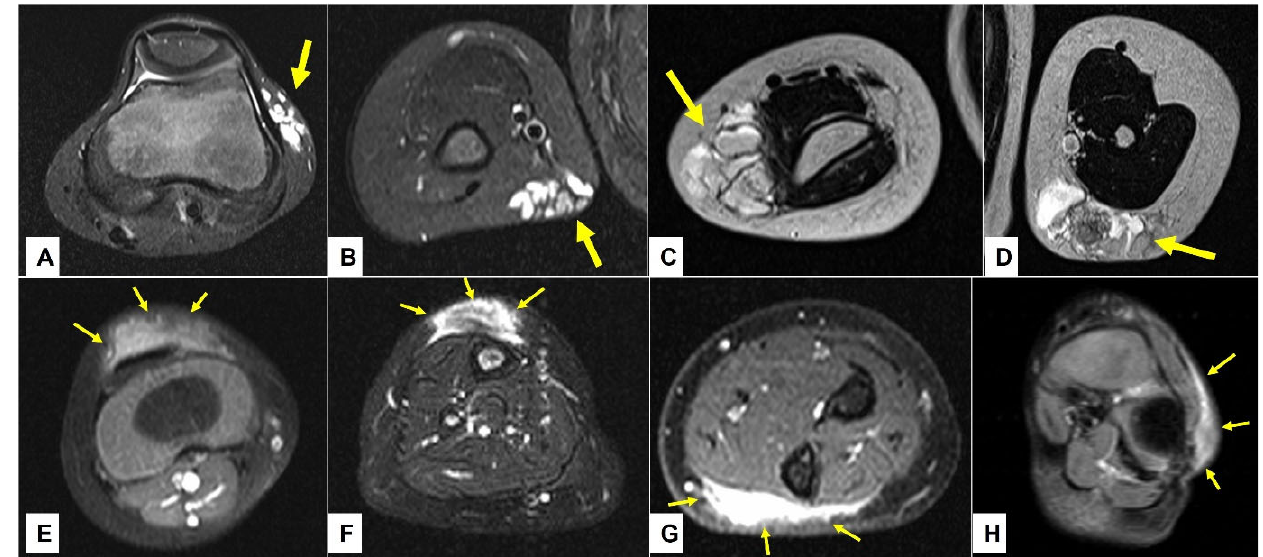
Figure 9. This composite figure illustrates the typical imaging differences between the low-flow subcutaneous vascular malformations (SVM) and subcutaneous granuloma annulare (SGA) as seen on the MR images. In images ( A – D ), four patients with multicystic subcutaneous lesions pointed out by yellow arrows are presented. These lesions were accurately diagnosed by MRI and after excision, also confirmed by histopathology as a venous malformation on the left knee in an 11-year-old boy ( A ); venous malformation on the right upper arm in a 4-year-old boy ( B ); lymphatic malformation on the right elbow in a 4-year-old girl ( C ); lymphatic malformation on the left upper arm in an 8-year-old girl ( D ). In images ( E – H ), four patients with homogenous subcutaneous lesions marked with 3 yellow arrows each are presented. These lesions remained inconclusive after MRI, with the main differential diagnosis being the low-flow SVM in all cases. Because malignancy could not be excluded, surgical biopsy was needed, and the diagnosis of SGA was confirmed by histopathology in all cases. ( E ) right knee in a 2.5-year-old boy, ( F ) right lower leg in a 3-year-old girl, ( G ) left forearm in a 4-year-old boy, ( H ) left foot in a 3-year-old girl. Note that all SVM have a cystic appearance on the MRI, whereas SGA shows the typical epifascial extension with gradual rise of the lesion towards the more superficial tissues, which we have named the “epifascial cap” sign. These self-limiting lesions show a homogenous appearance in the MRI and do not invade the fascia.